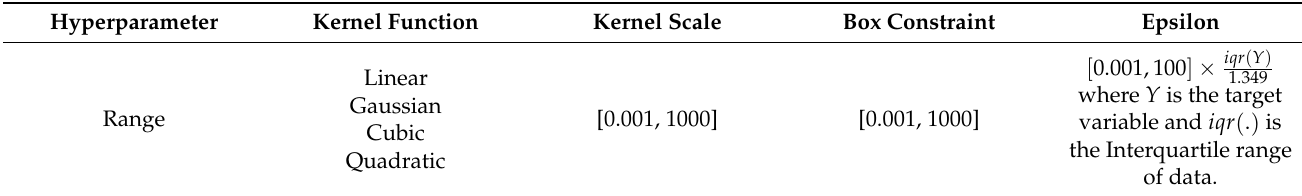
Table 1. The ranges of the SVM optimizable hyperparameters.